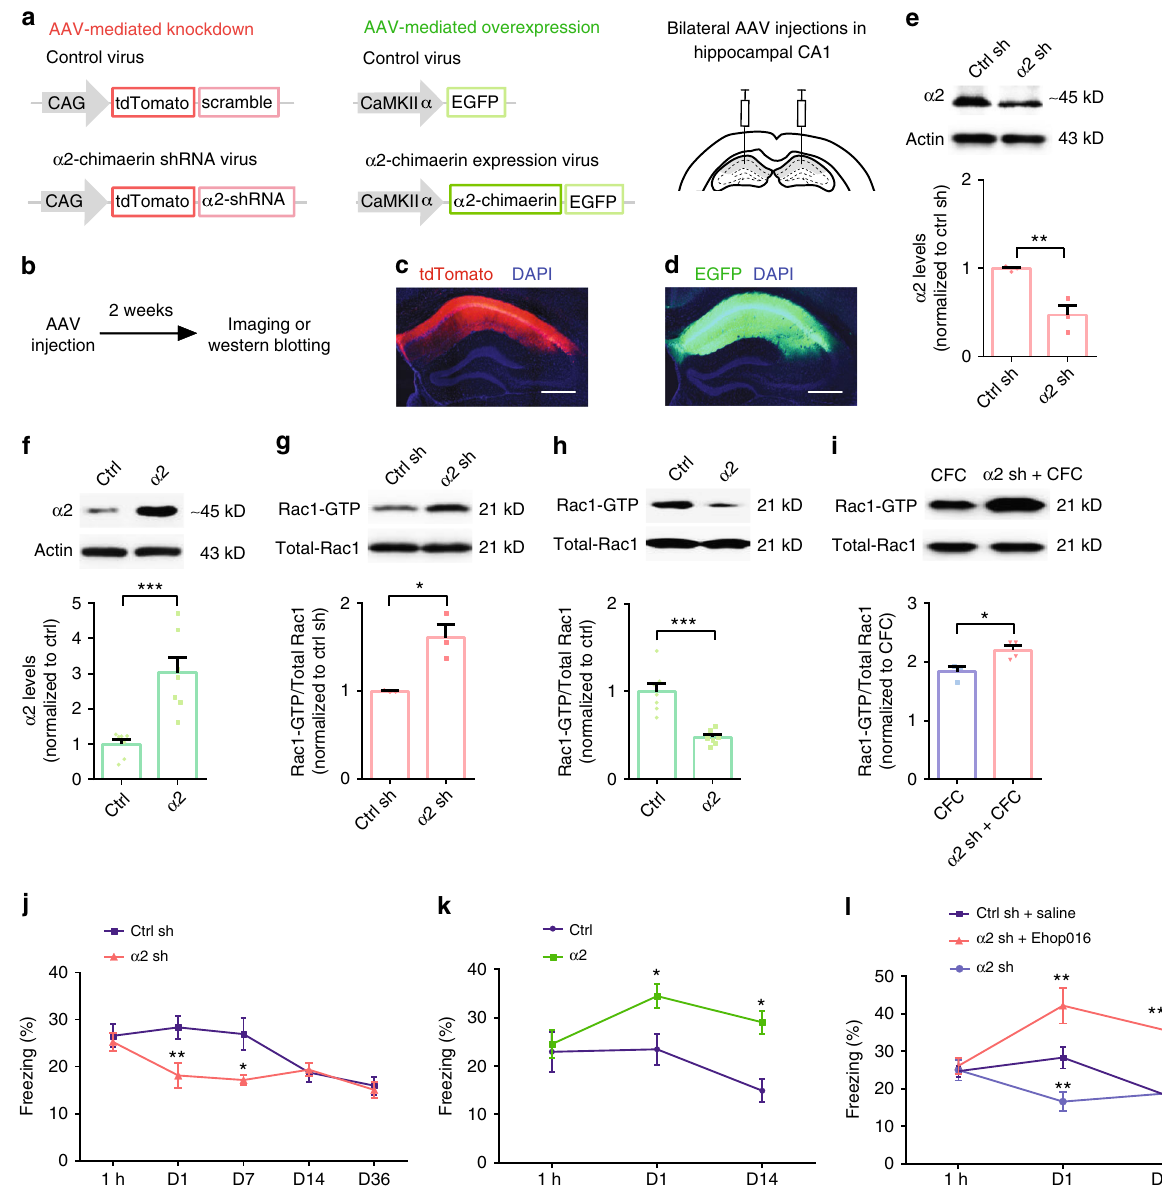
Fig. 4 Interplay between synthesis of α 2-chimaerin and Rac1 activity regulates dynamic memory maintenance. a Construction of AAVs and illustration of virus injection sites. b Experimental schedule. c , d Coronal section of the dorsal hippocampus with the viral injections and anti-nuclei (blue). Scale bar, 500 μ m. Bilateral AAV injection in dorsal hippocampus results in speci fi c expression of either tdTomato or EGFP in dorsal hippocampus. e – h Immunoblotting (top) and data (bottom) showing hippocampal α 2-chimaerin and Rac1 activity in mice injected with AAV- α 2 shRNA ( α 2 sh) or AAV- α 2-chimaerin ( α 2), as well as their respective controls. * P < 0.05, ** P < 0.01, and *** P < 0.001 (from unpaired t -test); n = 3, 3 mice ( e , g ), n = 7, 7 mice ( f , h ). i Immunoblotting (top) and data (bottom) illustrating hippocampal Rac1 activity of CFC mice and trained α 2 sh ( α 2 sh + CFC) mice at 1 day after training. * P < 0.05 (from unpaired t -test); n = 3, 4 mice. j – l Time courses of freezing in the ctrl sh (AAV-ctrl shRNA), α 2 sh, ctrl (AAV-ctrl), α 2, ctrl sh with saline treatment (ctrl sh + saline), α 2 sh with Ehop016 injection ( α 2 sh + Ehop016), and α 2 sh groups. * P < 0.05, ** P < 0.01, and **** P < 0.0001 (from two- way ANOVA); n = 7, 8, 15, 13, 11, 11, 16, 10, 9, 11 mice ( j ), n = 11, 13, 11, 13, 12, 7 mice ( k ), n = 3, 10, 10, 8, 12, 12, 5, 7, 9 mice ( l ). Data are presented as means ± SEM. Also see Supplementary Table